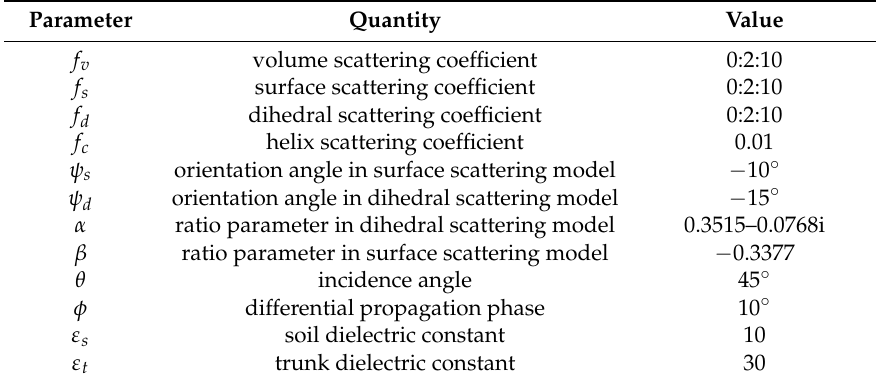
Table 1. Values for input